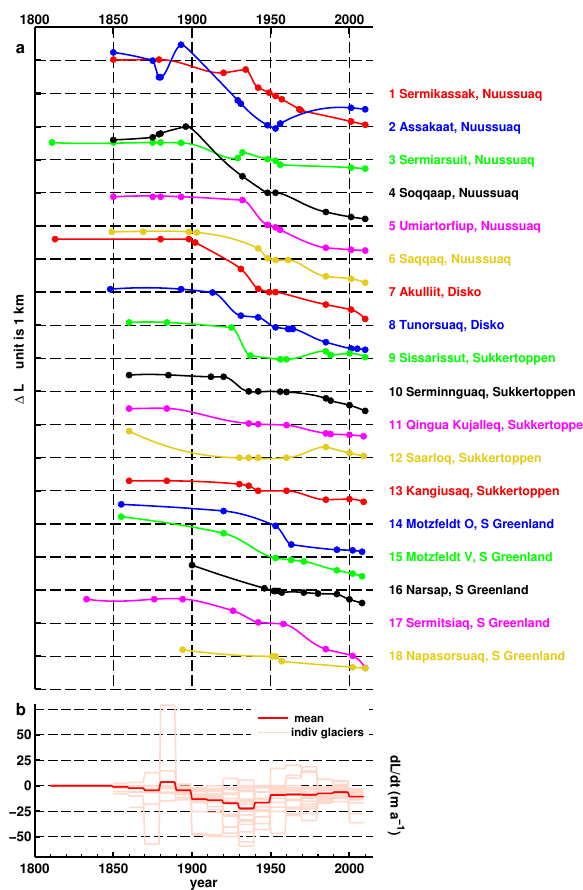
Fig. 2. (a) Length records of studied glaciers in West Greenland. Each dot represents a data point. Data are interpolated using Stine- man interpolation (Stineman, 1980). To record 1, data from Grib- bon (1970) were added; to record 8, data from Yde and Knudsen (2007); and to records 14, 15, 16, 17, and 18, data points from Wei- dick (1988) were added. (b) Rate of length change (ma − 1 ) averaged over 10-yr intervals in the period 1800–2010 for each of the glaciers (light coloured lines) and their average rate of length change